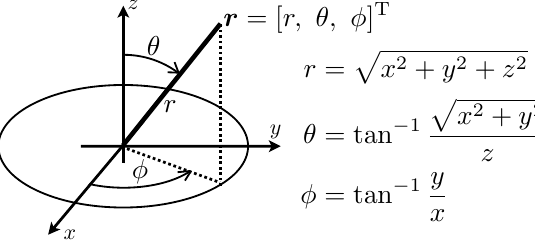
Figure 3. Definition of spherical coordinates relative to Cartesian